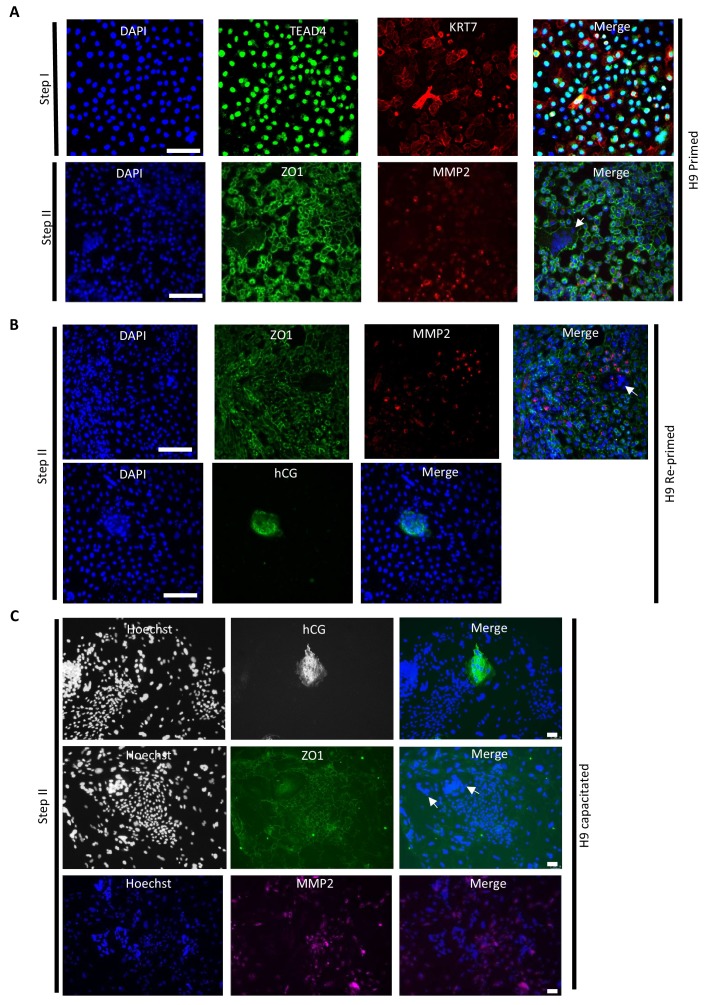
Immunofluorescence staining of trophoblast markers.(A) Immunofluorescence staining for TEAD4 and KRT7 in CTBs, and ZO1 and MMP2 in terminally differentiated trophoblasts derived from H9 primed hESCs. The scale bars indicate 75 μm. The white arrow indicates multinucleation. (B) Immunofluorescence staining for ZO1, MMP2, and hCG in terminally differentiated trophoblasts derived from H9 re-primed hESCs. The scale bars indicate 75 μm. The white arrow indicates multinucleation. (C) Immunofluorescence staining for hCG, ZO1, and MMP2 in terminally differentiated trophoblasts derived from H9 capacitated hPSCs. The scale bars indicate 75 μm. The white arrow indicates multinucleation.